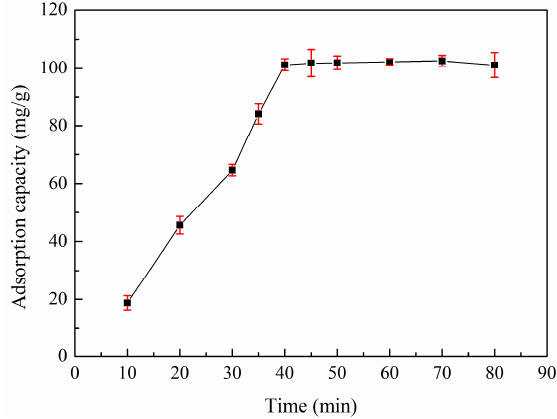
Figure 6. Effect of time on the adsorption capacity of XSBLAC for zinc(II). (Adsorption experiments- sample dosage: 0.05 g; initial zinc(II) concentration: 0.015 mol/L; pH value: 5.16; temperature: 60 °C;